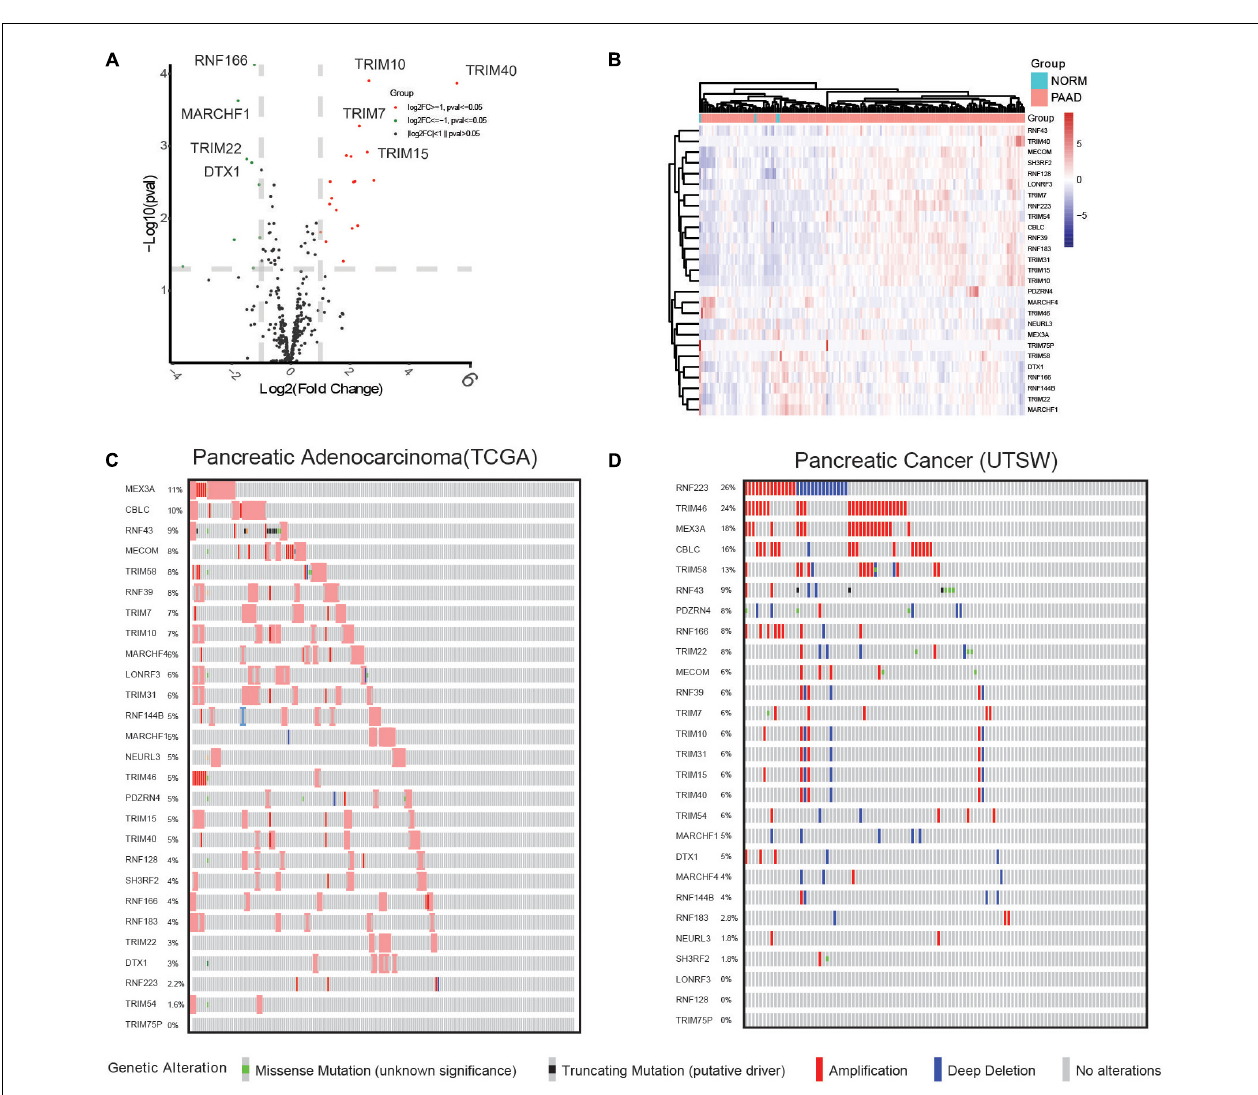
FIGURE 1 | Comprehensive analysis reveals 27 differentially expressed E3 ubiquitin ligase genes and their GAs in the TCGA pancreatic cancer (PAAD) dataset. (A) Differential analysis of E3 ubiquitin ligases identified differentially expressed genes, shown in a volcano plot. Upregulated genes are shown as red dots, downregulated genes are shown as green dots, and genes with no significant differential expression are shown as gray dots. (B) Supervised hierarchical clustering of the DEGs in pancreatic cancer and normal samples. (C) Genetic alterations in pancreatic cancer samples included in the TCGA PAAD dataset. (D) Genetic alterations in pancreatic cancer samples included in the UTSW